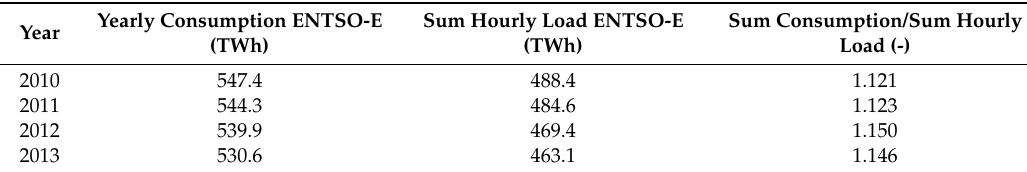
Table 2. Comparison consumption and hourly load ENTSO-E